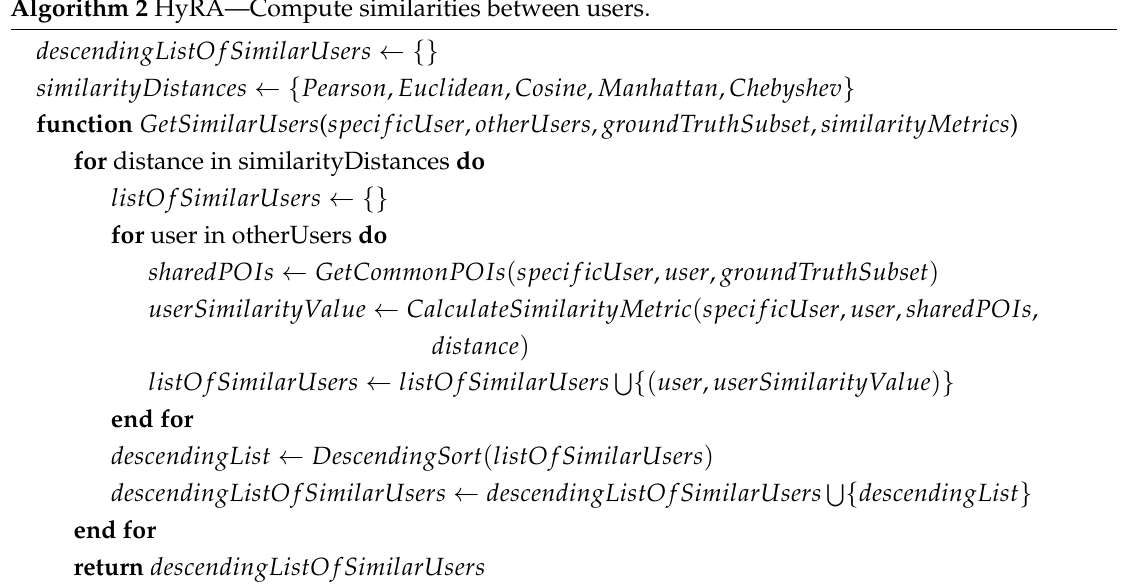
Algorithm 2 HyRA—Compute similarities between